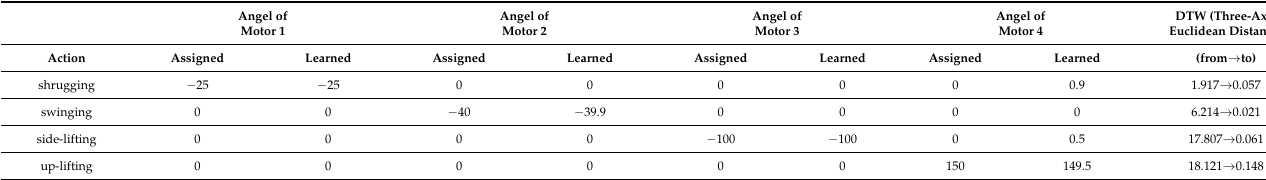
Table 1. The experimental results of motors with the same starting